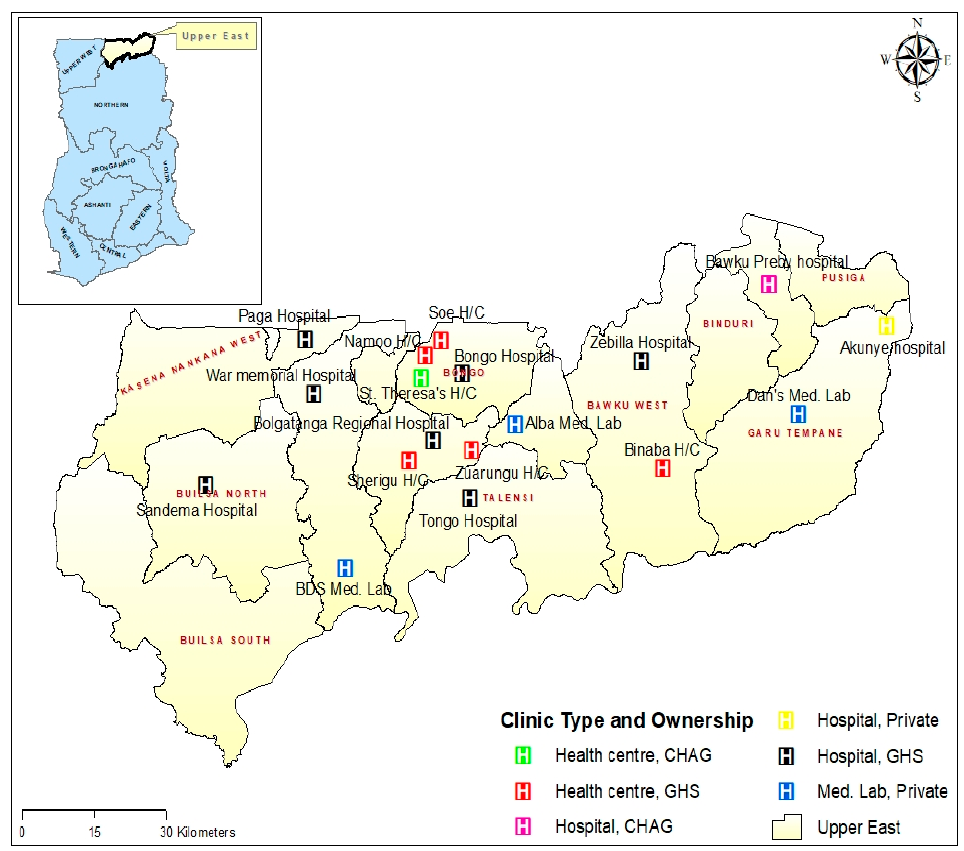
Figure 2. Map showing the geographical location, facility type, and ownership of health facilities providing blood type testing services in the Upper East Region (UER). CHAG—Christian Health Association of Ghana; GHS—Ghana Health Services.